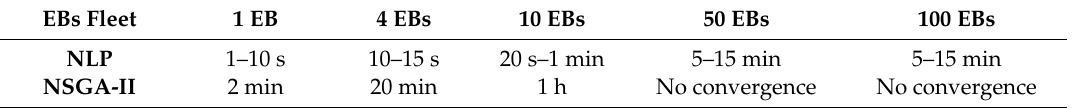
Table 2. CPU (Central Processing Unit) time.